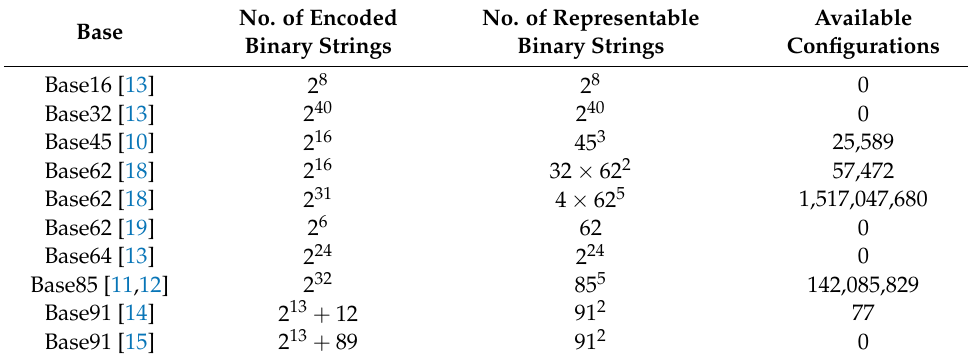
Table 1. Summary of the main encodings’